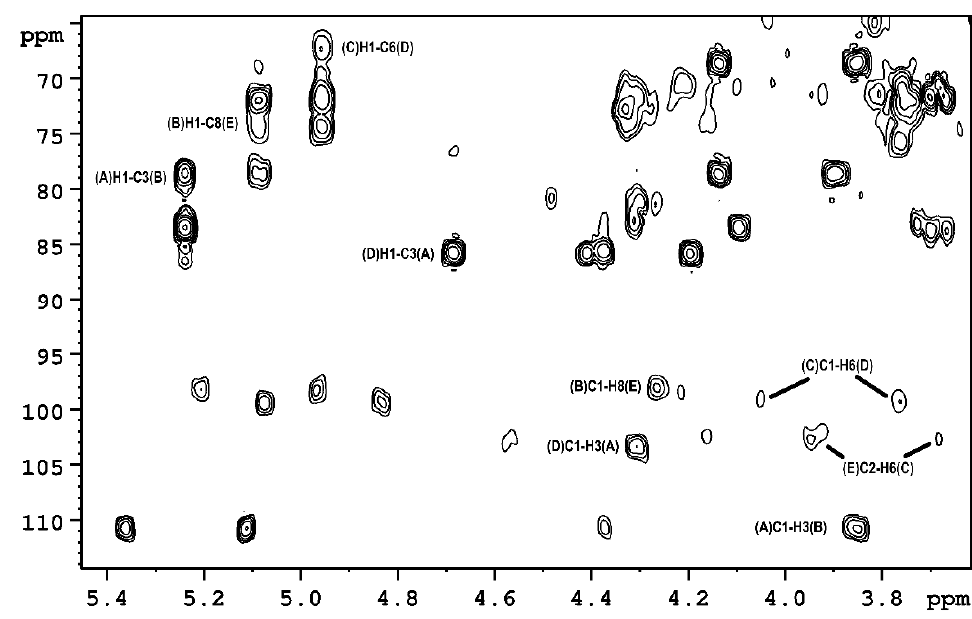
Figure 2. The section of HMBC spectrum of the OPS isolated from P. parmentieri